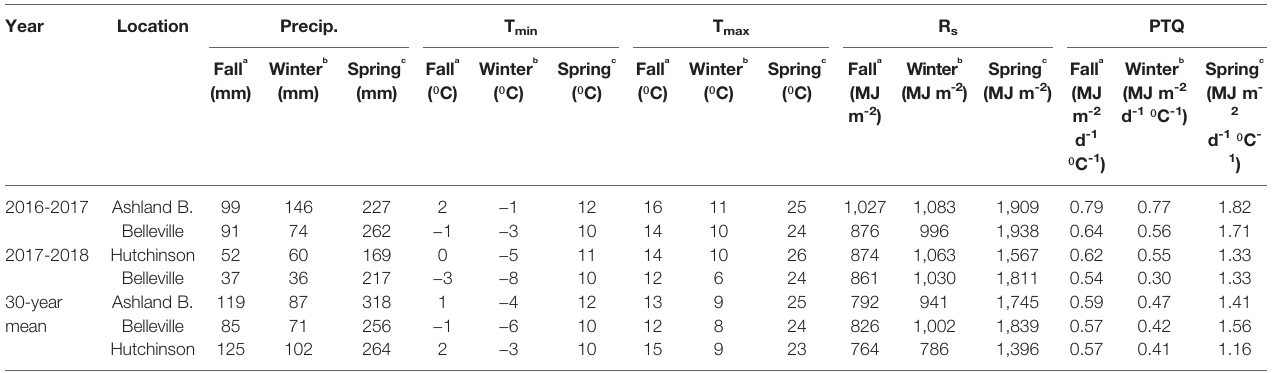
TABLE 2 | Cumulative precipitation (Precip.), average maximum (T max ), and minimum temperatures (T min ), cumulative solar radiation (R s ) in (MJ m -2 ), and average photothermal quotient (PTQ) for each portion of growing season during 2016-2017 and 2017-2018 at Ashland Bottoms, Belleville, and Hutchinson, KS. Year